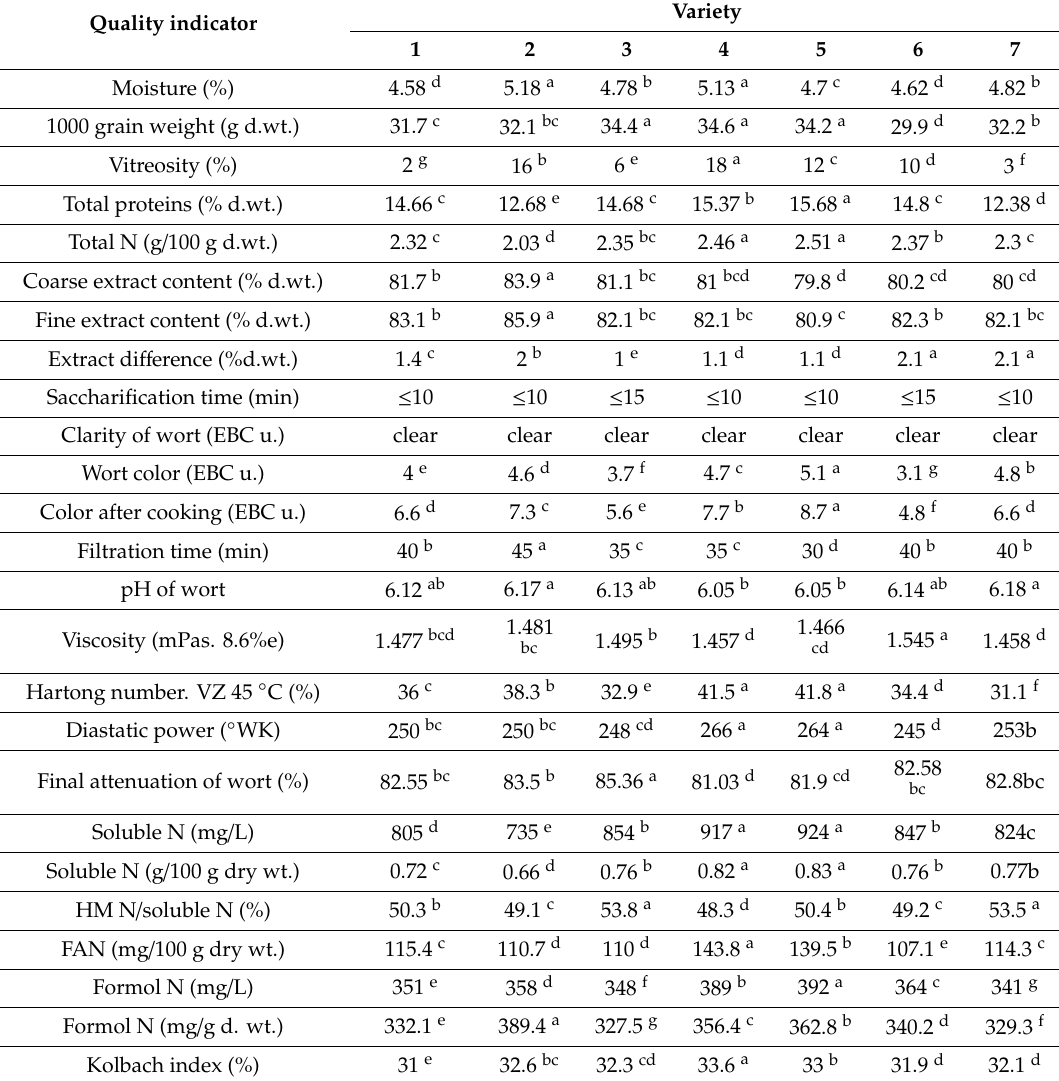
Values are the mean obtained with three measurements. Values displayed in the same lines and tagged with di ff erent letters (a–g) are significantly di ff erent ( p <